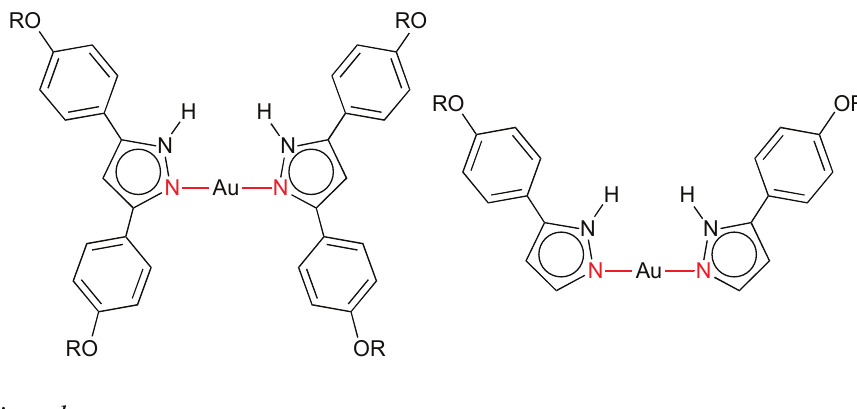
H , C H 12 25 14 29